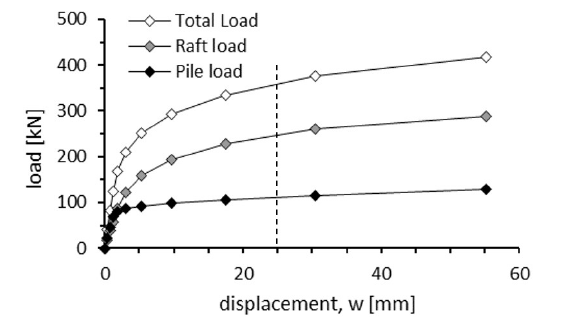
Figure 17. Load-settlement curves for case 10 - L=5m;